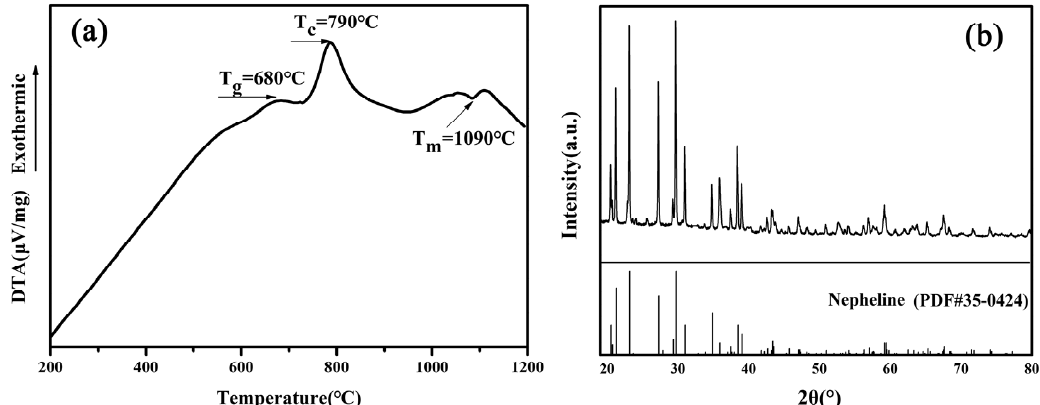
Figure 3. ( a ) DTA curve of the parent glass and ( b ) XRD pattern of a glass-ceramic sample nucleated